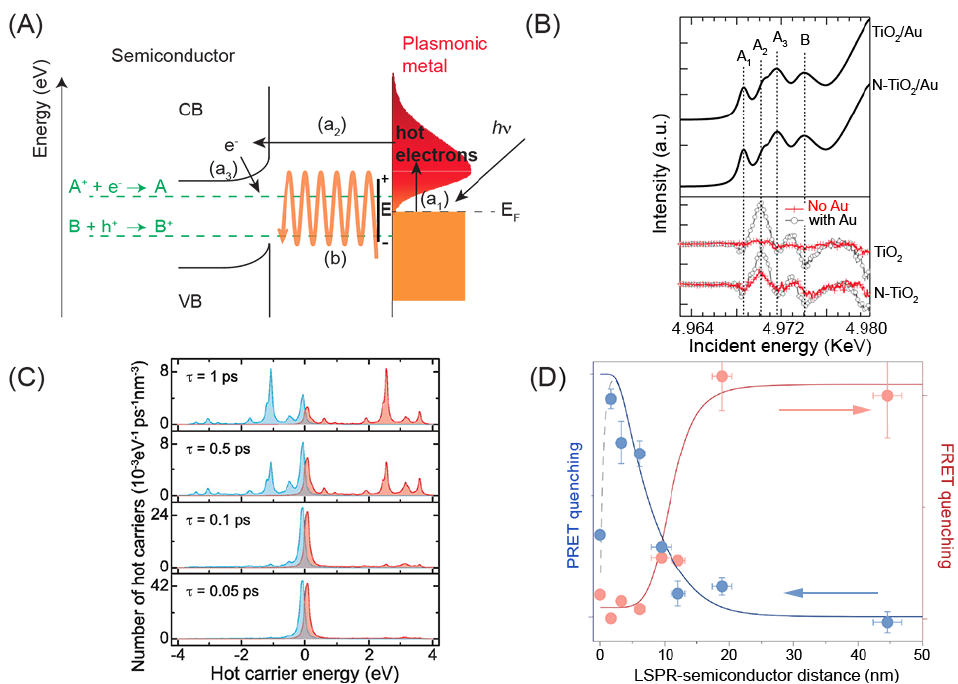
Figure 2: Interaction between semiconductor and plasmonic nanostructures: (A) Mechanism of LSPR-induced charge transfer (a x ) and field enhancement (b). Dashed green lines refer to the redox potentials of a generic molecular species. (a 1 ) Electrons near the metal Fermi level, E F are excited to surface plasmon states; (a 2 ) hot electrons transfer to a nearby semiconductor particle; (a 3 ) electron-driven reduction of chemical species; (b) electric field propagation toward the semiconductor electronic structure. (B) Effects of hot electron injection in TiO 2 /Au composites measured through high res x-ray absorption spectroscopy. TiO 2 /Au and N-TiO 2 /Au laser-off pre-edges (top panel). Laser-on/laser-off spectral differences (bottom panel) on bare TiO 2 /Au powders (line with vertical ticks) and plasmonic TiO 2 /Au powders (line with empty circles). (C) Hot carrier energy distribution (hot electrons and hot holes represented with red and blue plots, respectively) calculated for nanoparticle diameter of 15 nm. (D) The distance dependence of PIRET in Au@SiO 2 @Cu 2 O materials. Figures (B), (C), and (D) adapted with permission from references [ ? ? ] and [ ? ], respectively. (B) Copyright (2015) Wiley. (C) Copyright (2014) American Chemical Society. (D) Copyright (2015) Nature Publishing